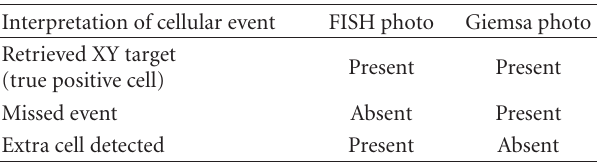
Table 1: Interpretation of cellular events according to the concor- dance of the FISH images resulting from scanning and previously taken Giemsa